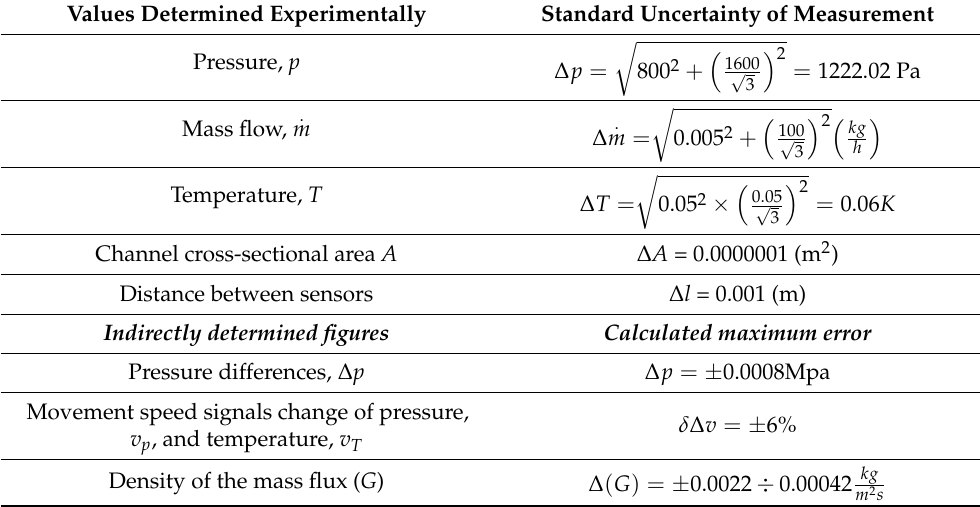
Table 1. Summary of measurement